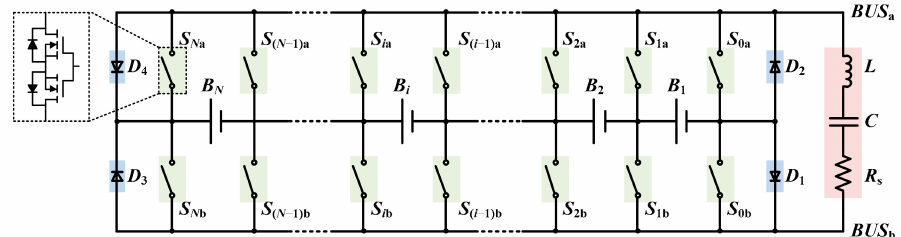
Figure 5. Circuit structure of the proposed BRLCC equalizer for N